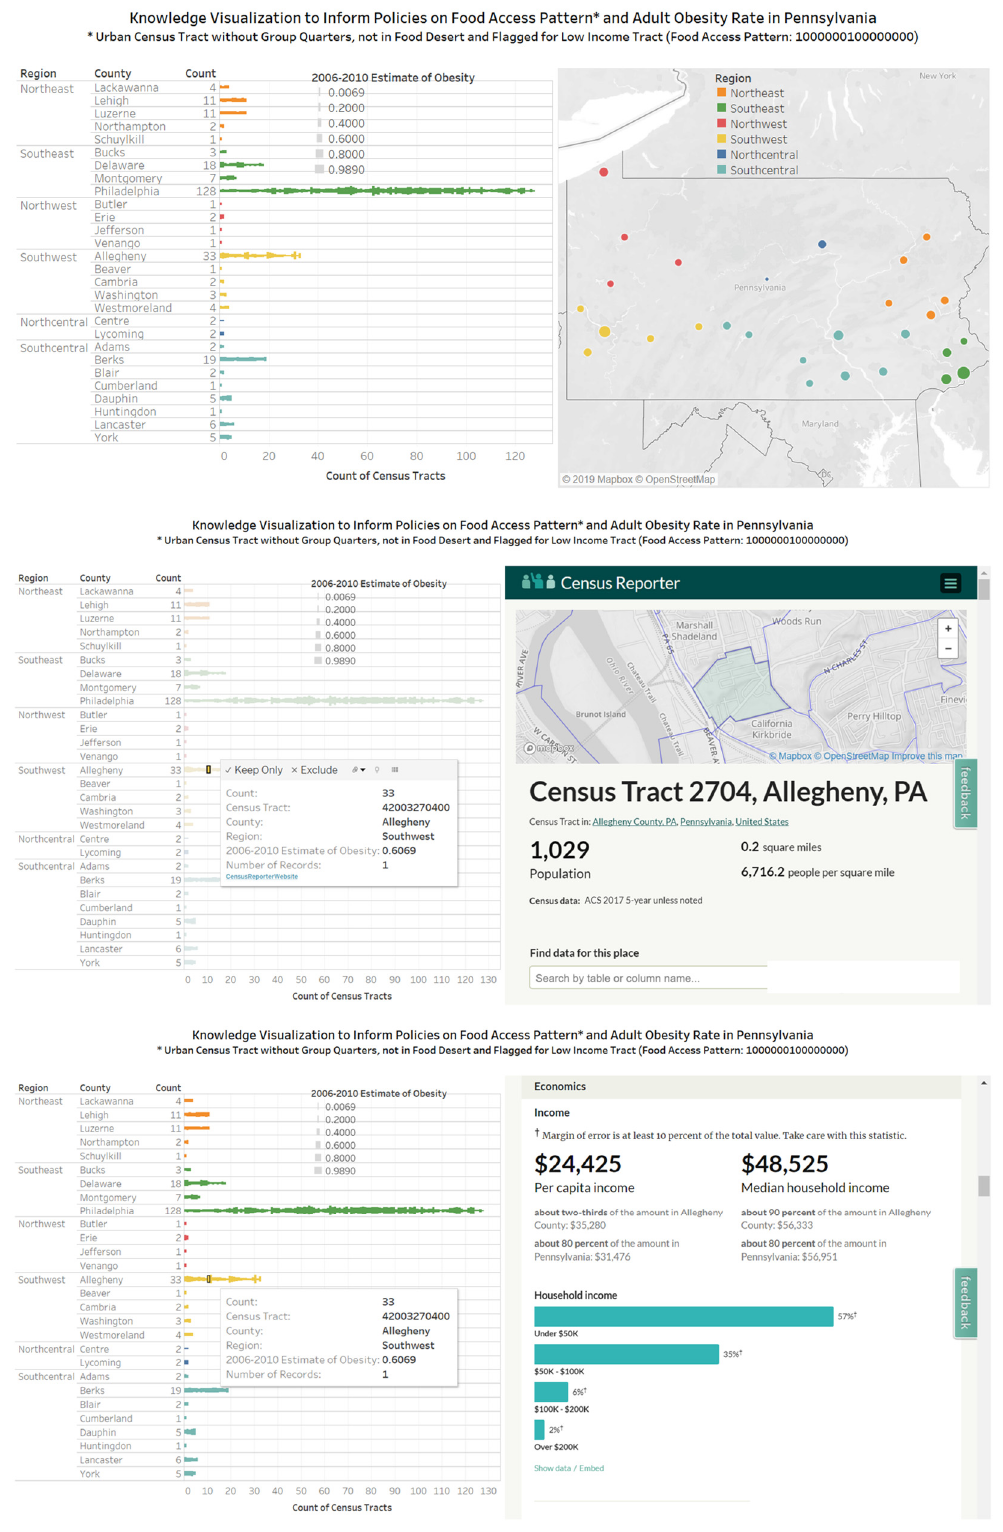
Figure 12. Bar plot of estimates of obesity rates (2006–2010) for census tracts with the same food access pattern and connected to geographic map or website. The design of the views allows for knowledge visualization benefits of coordination, attention, recall, motivation, elaboration and new insights.